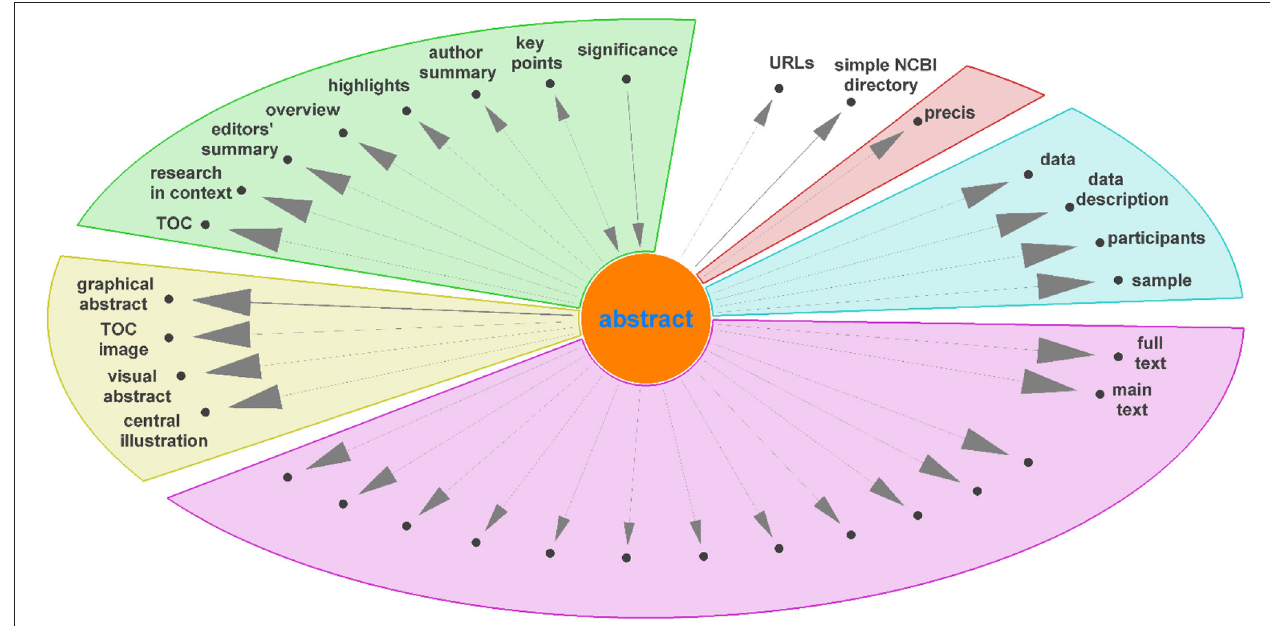
FIGURE 4 | Unmapped nodes in the digraph ( Figure 3 ) connected to “abstract” as ego node, excluding corpus specific nodes, grouped into different categories. Unlabeled nodes are titles of paragraphs in the main text.